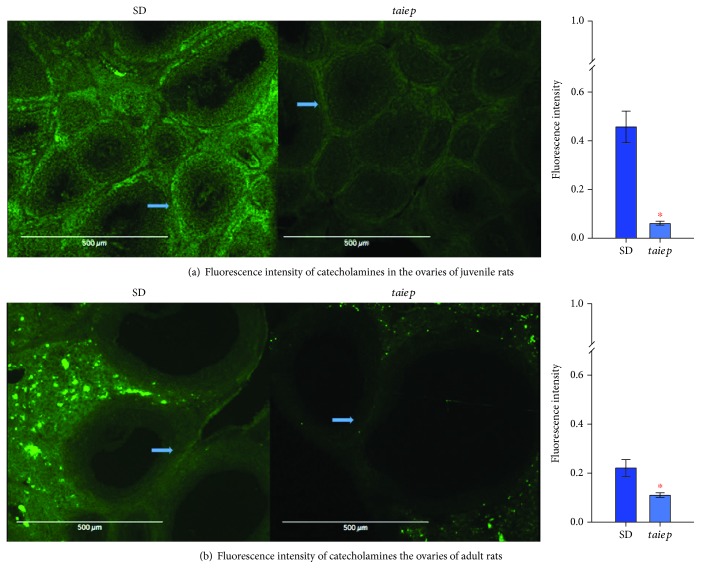
Fluorescence intensity of catecholamines in the ovaries of juvenile and adult Sprague–Dawley and taiep rats. (a) Immunohistochemistry of an ovary slice of juvenile Sprague–Dawley and taiep rats; arrows indicate the location of the fluorescent around the follicle; the bar graph shows fluorescence intensity. The error bars represent the standard error of measurements for 30 sections of ovaries by group. (b) Immunohistochemistry of an ovary slice of adult Sprague–Dawley and taiep rats; arrows indicate the location of the fluorescents, and the bar graph shows fluorescence intensity. SD: Sprague–Dawley. The error bars represent the standard error of measurements for 30 sections of ovaries by group. ∗p ≤ 0.01 Student's t-test.